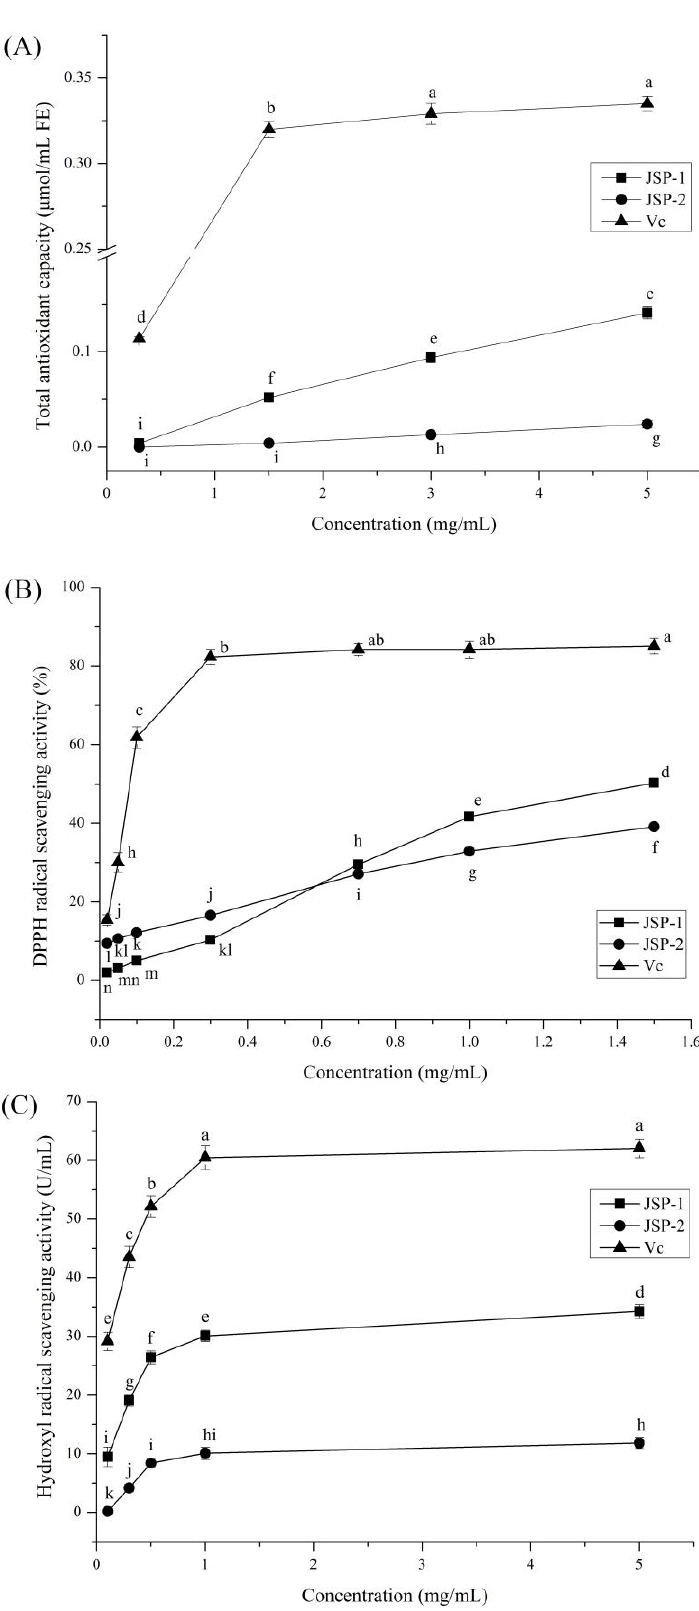
Figure 2. Antioxidant activities of Jasminum sambac flower polysaccharide (JSP) sub-fractions. ( A ) total antioxidant capacity (T-AOC), ( B ) 2,2-Diphenyl-1-picrylhydrazyl (DPPH), and ( C ) hydroxyl radical ( • OH) scavenging activities. Values within each sample, denoted by various letters in the diagram, were statistically different, p < 0.05.